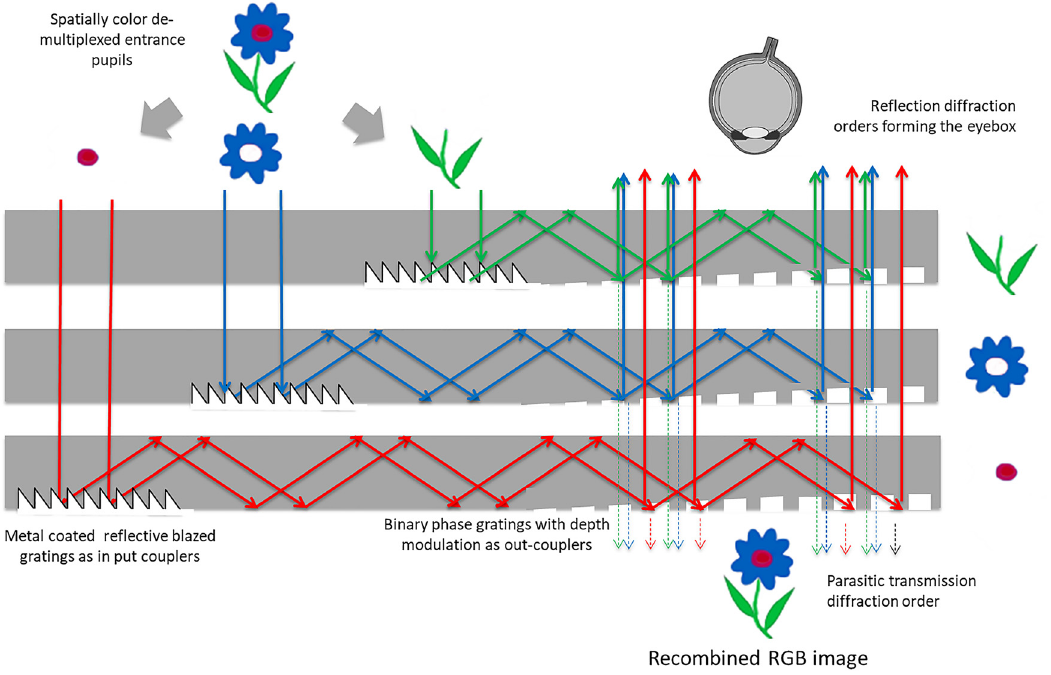
Figure 14: Spatially color-demultiplexed input pupils with 100% reflective blazed gratings as in-couplers and binary phase gratings as out- couplers (Magic Leap One MR